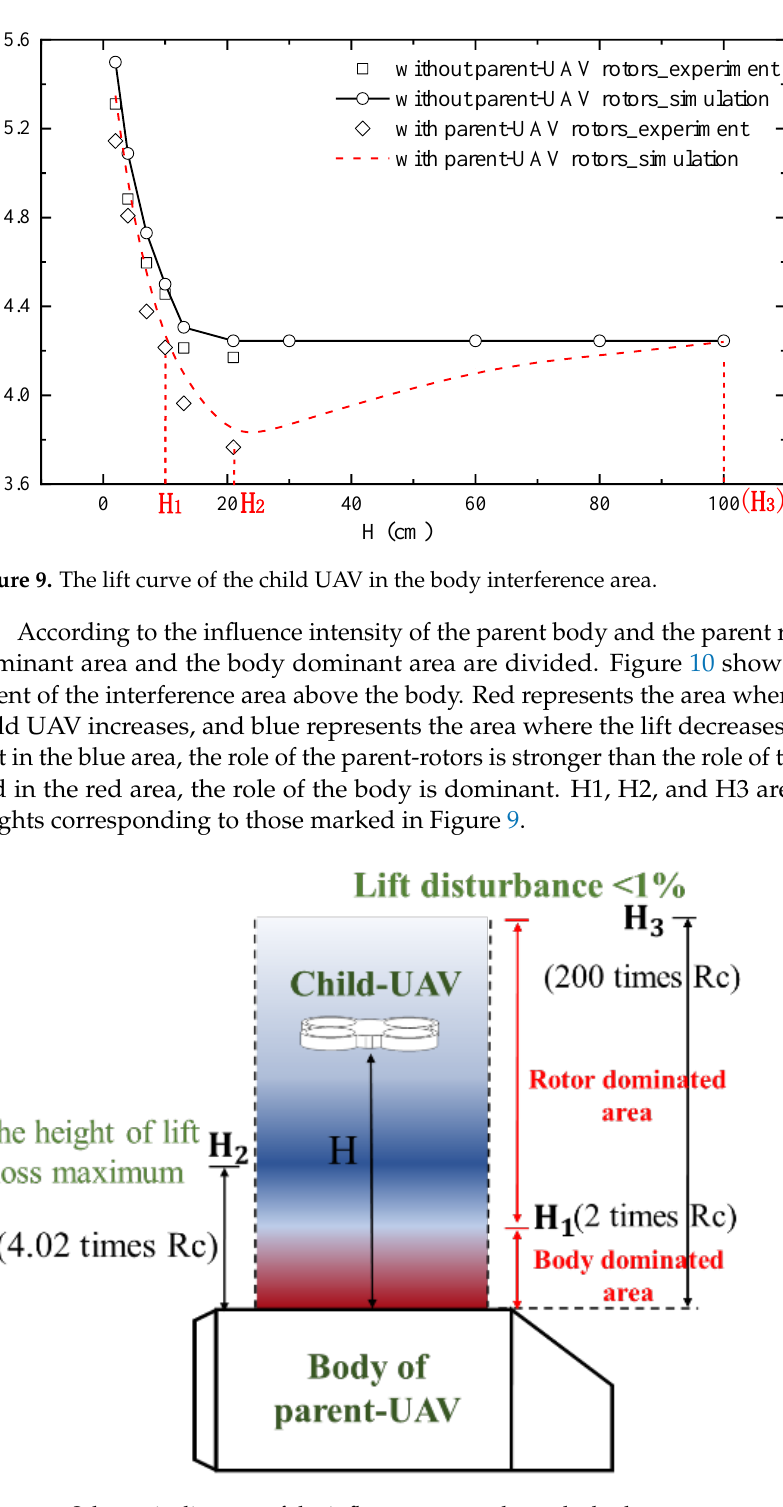
Figure 10. Schematic diagram of the influence extent above the body.